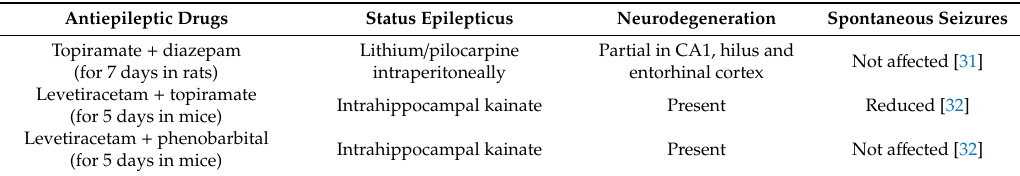
Table 3. Influence of combinations of antiepileptic drugs on neurodegeneration and spontaneous seizure activity produced by status epilepticus in